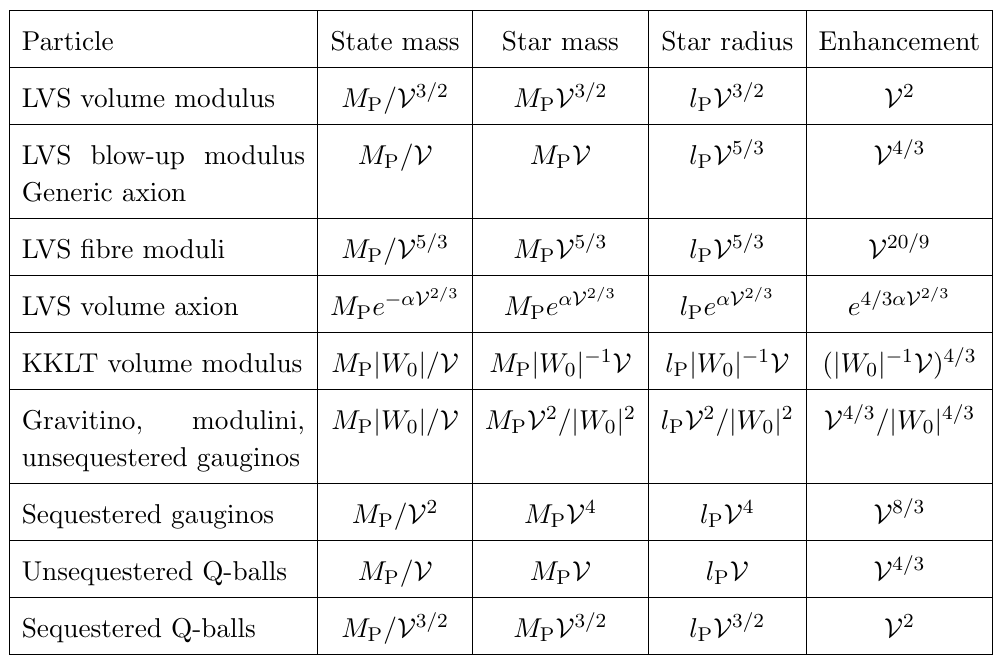
Table 2 . Summary of the compact con(cid:12)gurations with the scalings of their associated particle and star mass scalings, radii, and their respective enhancement